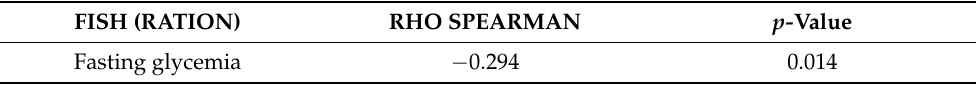
Table A11. Association between lower fish consumption and higher glucose intolerance at baseline O’Sullivan.